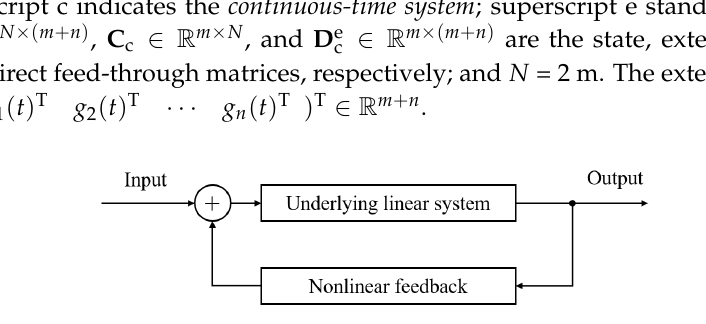
Figure 1. The feedback interpretation of nonlinear vibrating